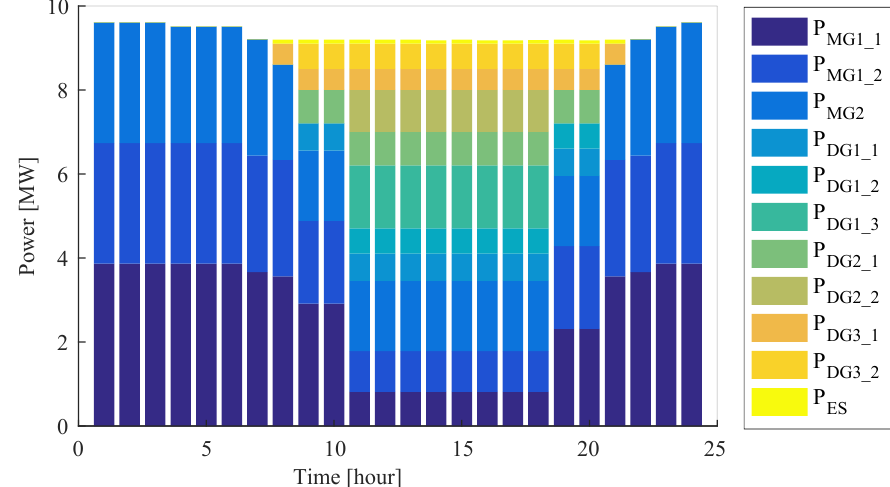
Figure 6. Power dispatch of power generators in microgrids.